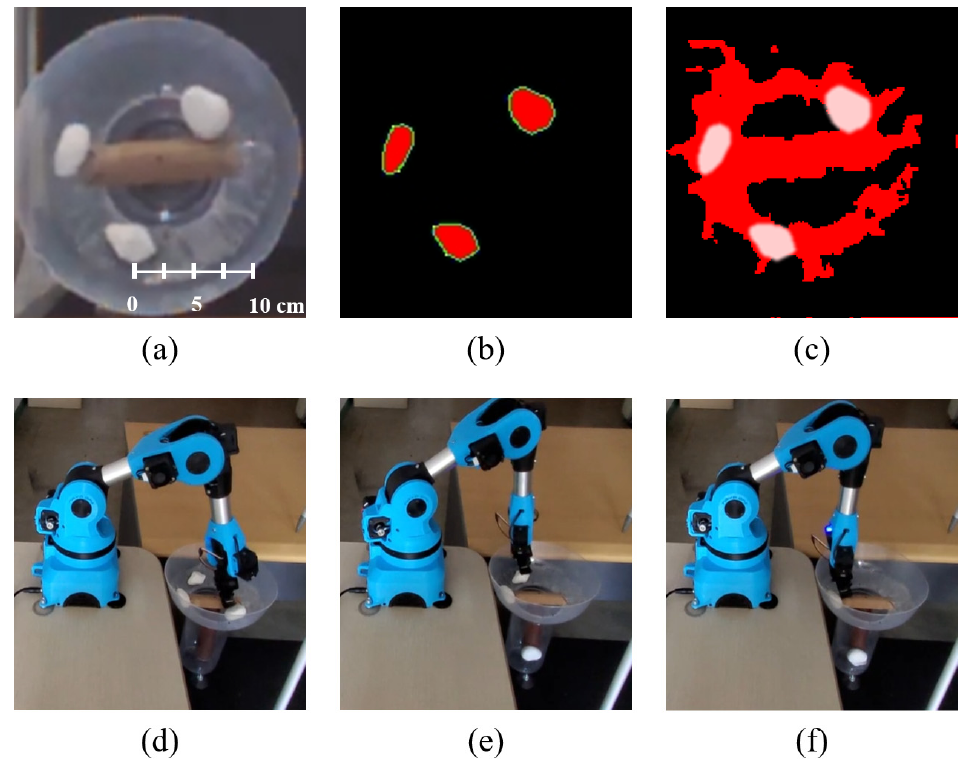
Figure 15. Experimental results obtained using the proposed smart hopper system in the case involving three rocks above the hopper. ( a ) RGB image, ( b ) binary image of detected rocks, ( c ) classified rocks by depth image, ( d ) Operation of the robot arm on the first rock, ( e ) that on the second rock, and ( f ) that on the third rock. Table 3. Experimental results of the RGB-D camera and the robot arm coordinates of the detected rocks. Num.